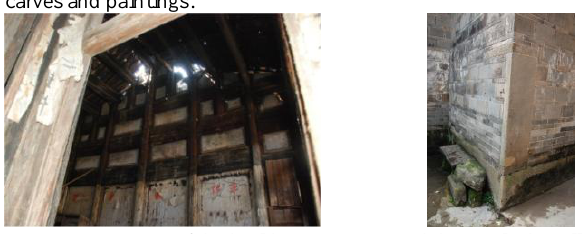
Figure 8. Pictures of the building structure and the rowlock